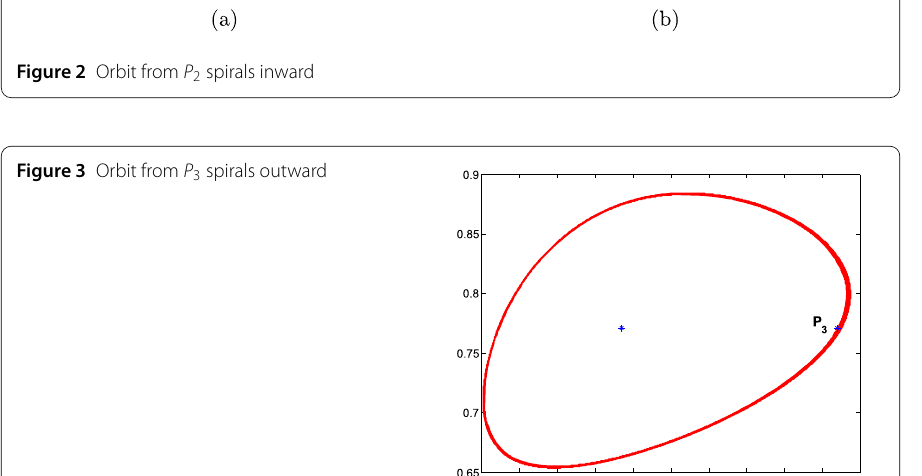
Figure 2 Orbit from P 2 spirals inward